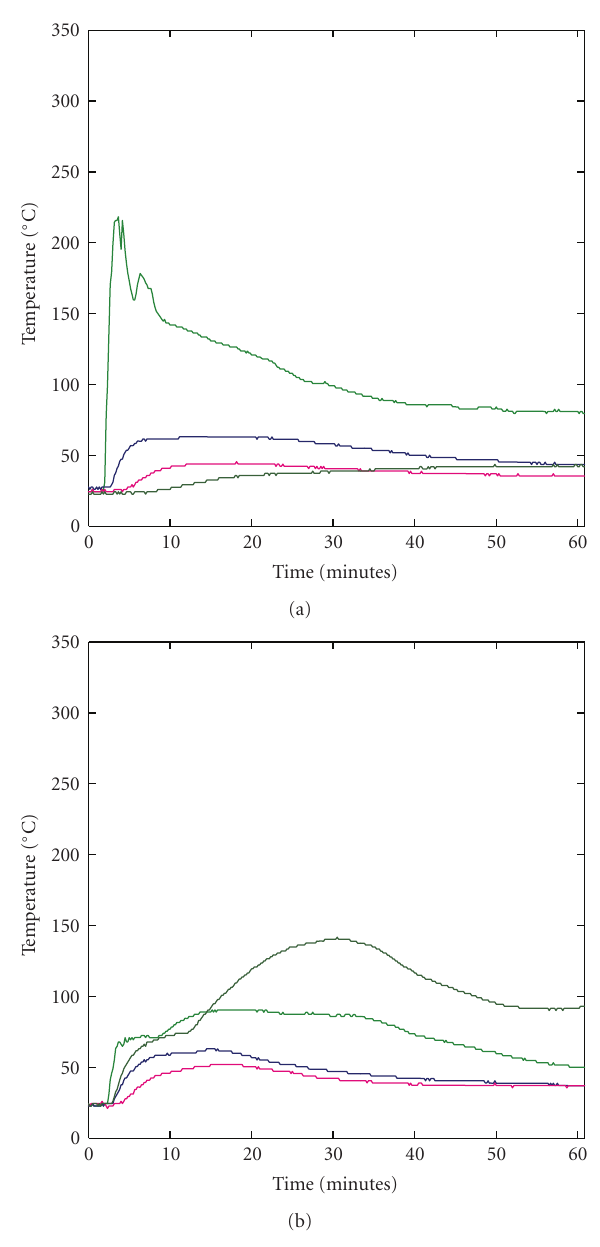
Figure 4: Soil temperatures at 2cm depth during a prescribed sand pine scrub fire at Archbold Biological Station, Florida on May 25, 1993. Temperatures were recorded with copper-constantan thermocouples placed in vegetated (a) and open (b) microsites. Each microsite location was replicated four times.